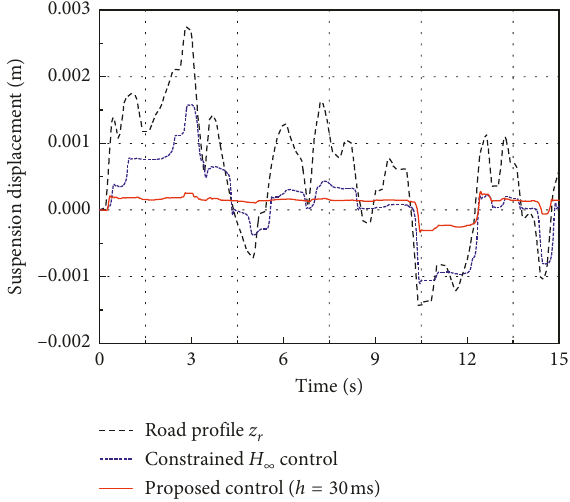
Figure 17: Hardware results of suspension displacement under random road signal.